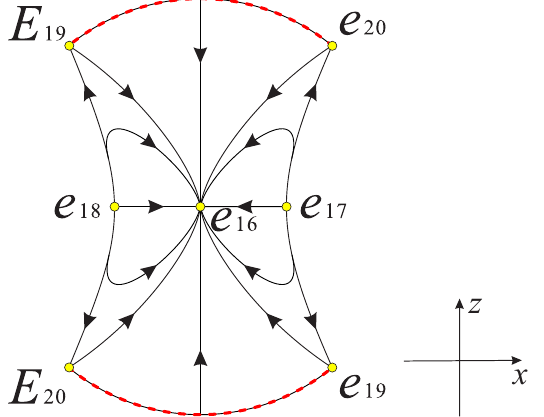
Figure 29. The global phase portrait of system (39) on the invariant plane u = 0 restricted to the region x 2 − z 2 ≤ 1. E 19 and E 20 are the diametrically opposite points of e 19 and e 20 on Poincaré disc,